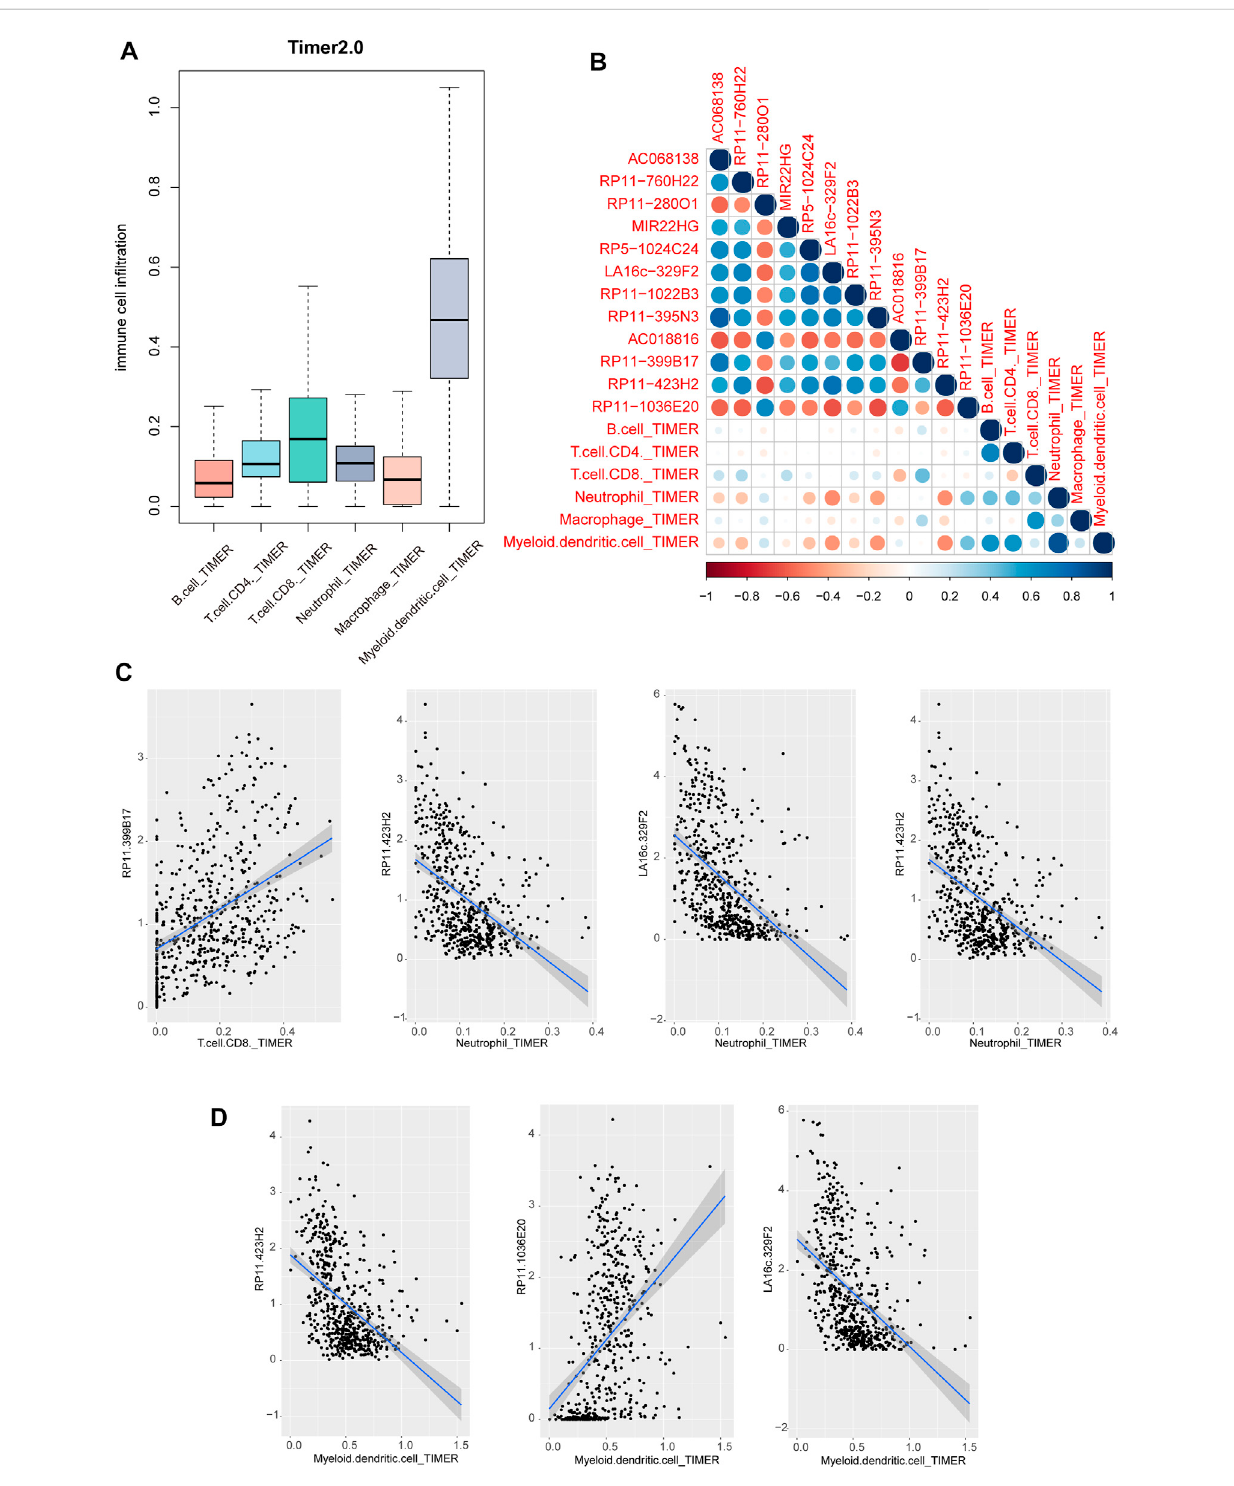
FIGURE 6 Immune cell in fi ltration of lncRNAs in THCA. (A) Immune cell in fi ltration levels of six type immune cells of TCGA patients in TIMER 2.0 database (B) The correlation heatmap of correlation coef fi cients between lncRNA expression and immune cell in fi ltration score. (C – D) Scatter plots of correlations between lncRNA expression and TIMER2 immune cell in fi ltration